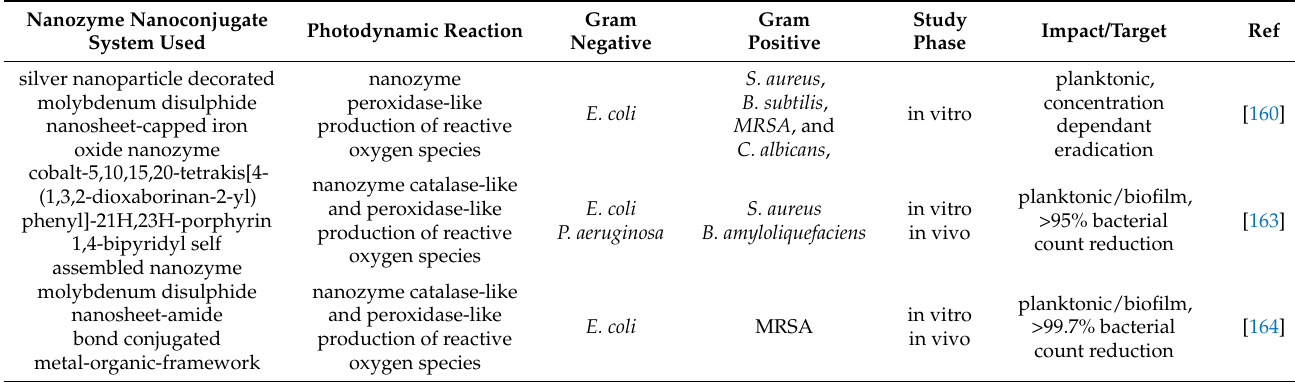
Table 8. Nanozyme enhanced antimicrobial photodynamic